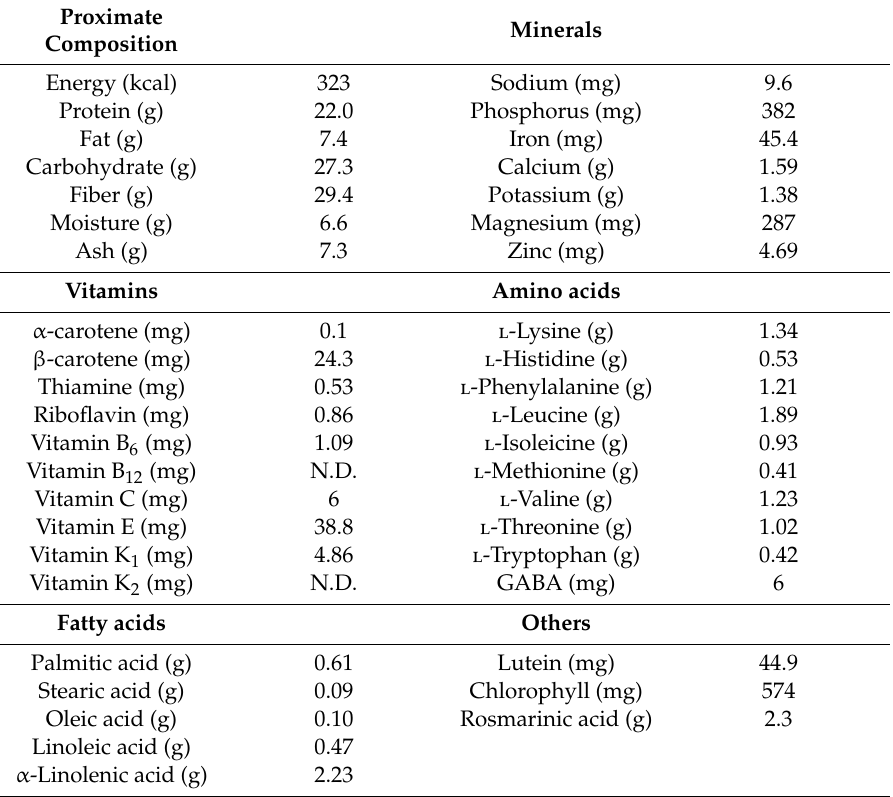
Table 6. Nutrient composition of the leaf powder of Perilla frutescens var. frutescens dried using a microwave under reduced